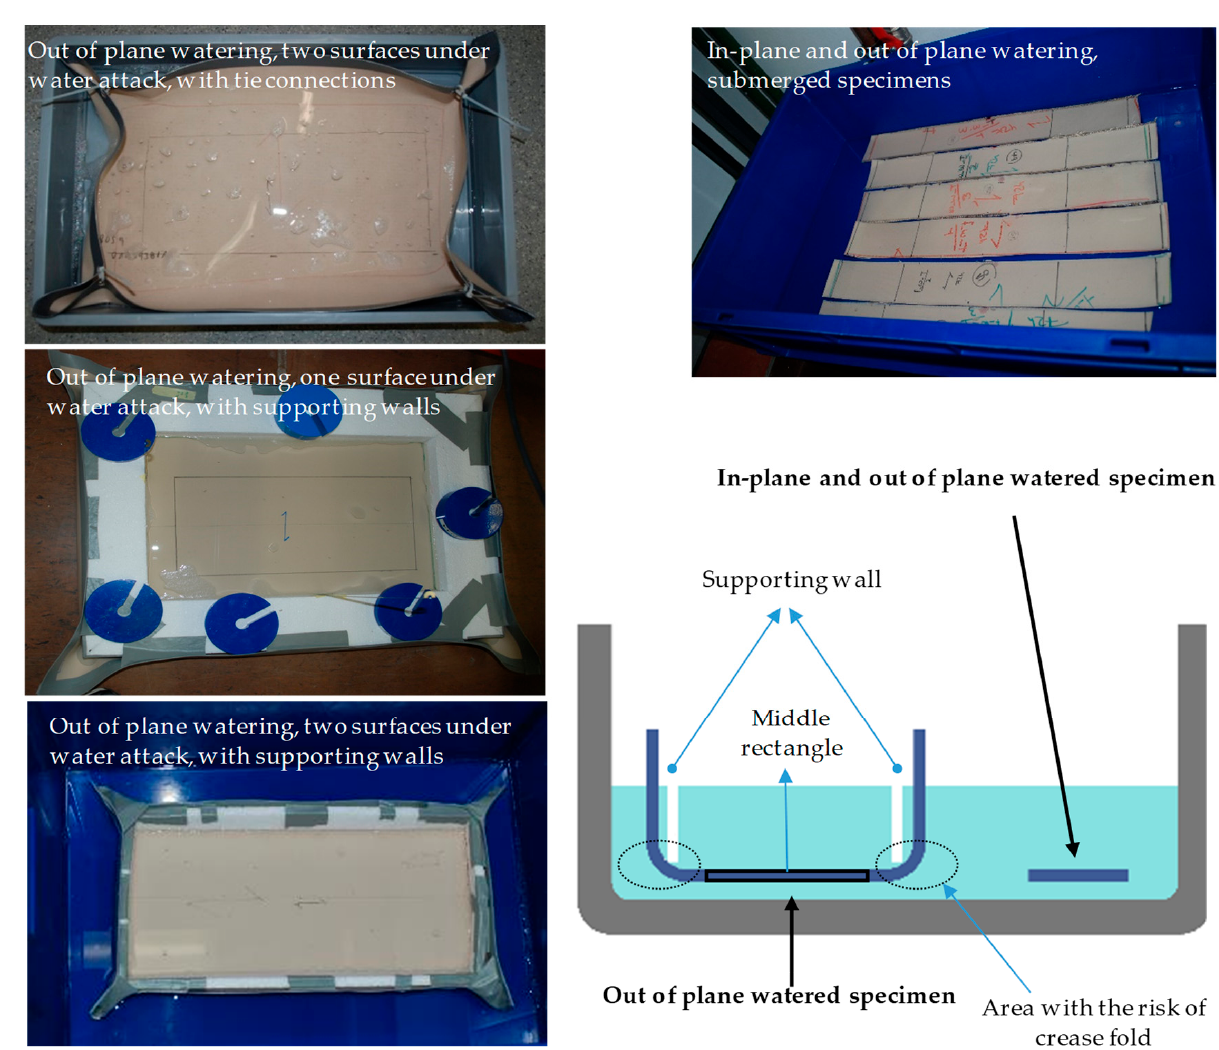
Figure 6. Investigated water seepage mechanisms of glass-PTFE specimens.